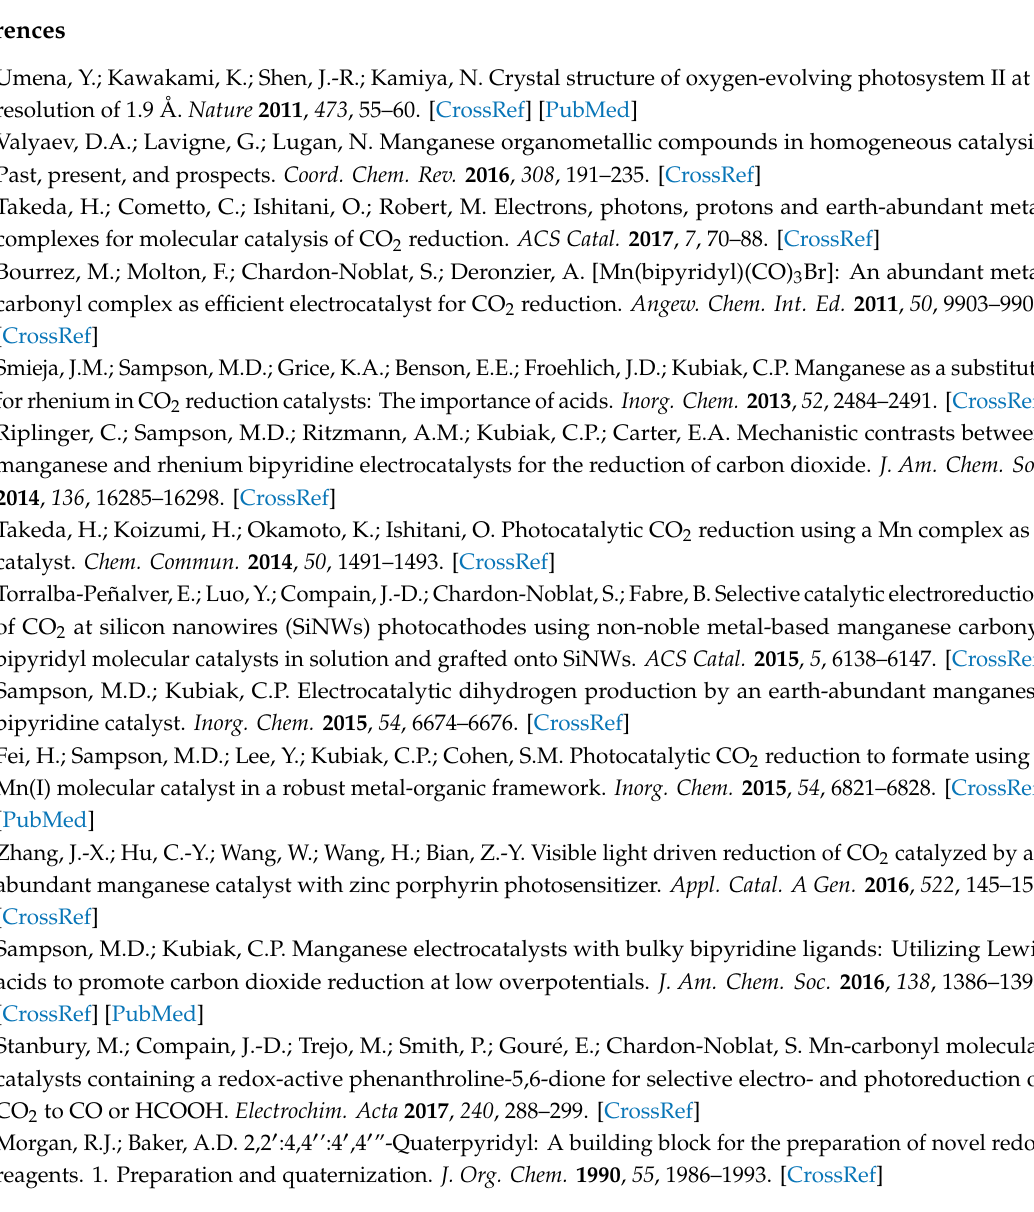
Supplementary Materials: Figure S1: A dimer formation caused by intermolecular hydrogen bonds and π - π stacking in the crystal packing of Mn-dpc . Figure S2: Cyclic voltammogram of Mn-qpy in DMF ( v = 0.1 V s –1 , c = 0.5 mM). Figure S3: Cyclic voltammogram of Mn-dmqpy in DMF ( v = 0.1 V s –1 , c = 1 mM). Table S1: Hydrogen-bond geometry (Å, ◦ ) for Mn-dpq and Mn-dpc . Table S2: Hydrogen-bond geometry (Å, ◦ ) for Mn-qpy and Mn-dmqpy